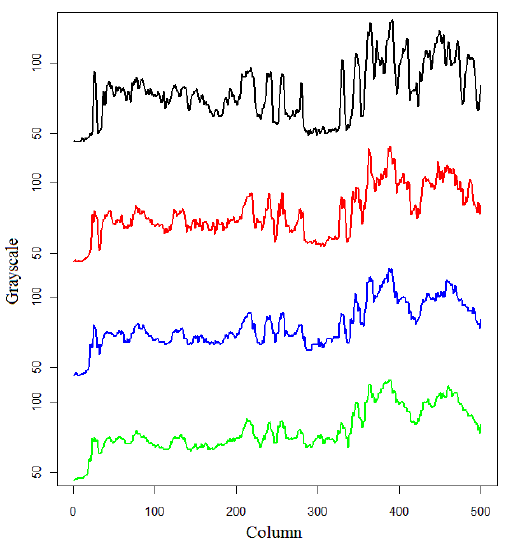
Figure 7. A-A sectional